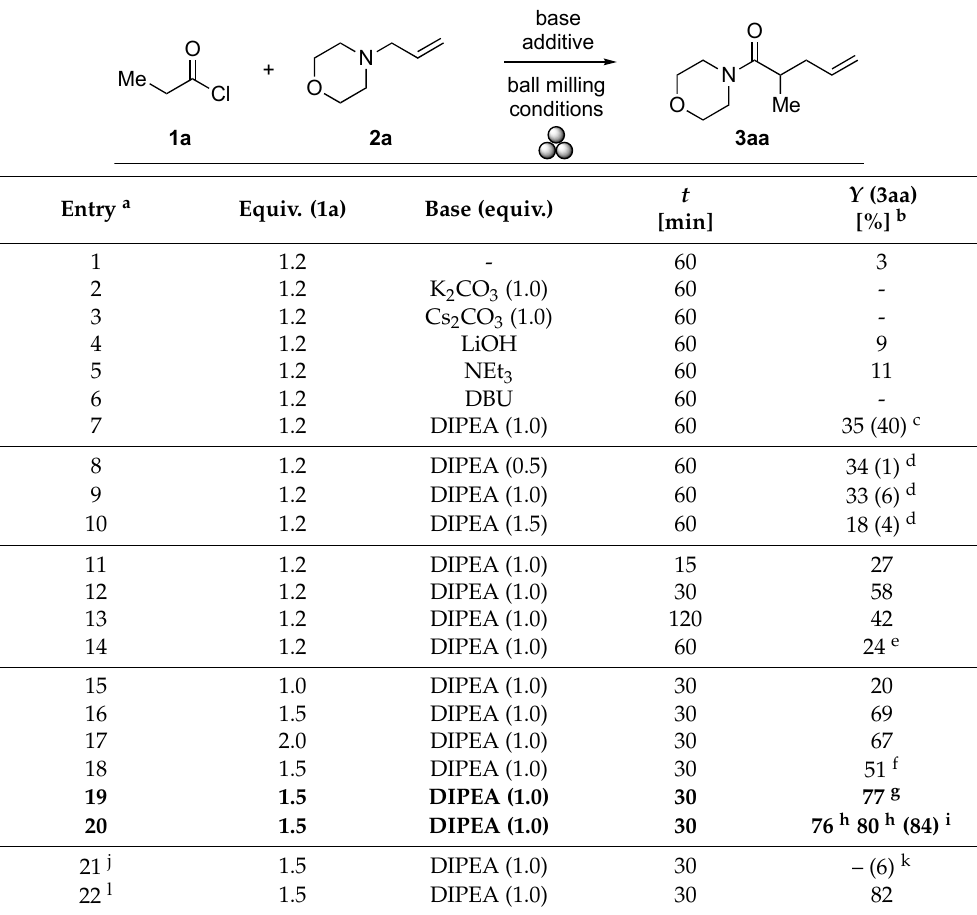
amide enolate or favor the dehydrohalogenation [62,122,123]. However, with DBU, no product was formed (Table 1, entry 6). Table 1. Optimization of the mechanochemical synthesis of amide 3aa . Table 1. Optimization of the mechanochemical synthesis of amide 3aa .